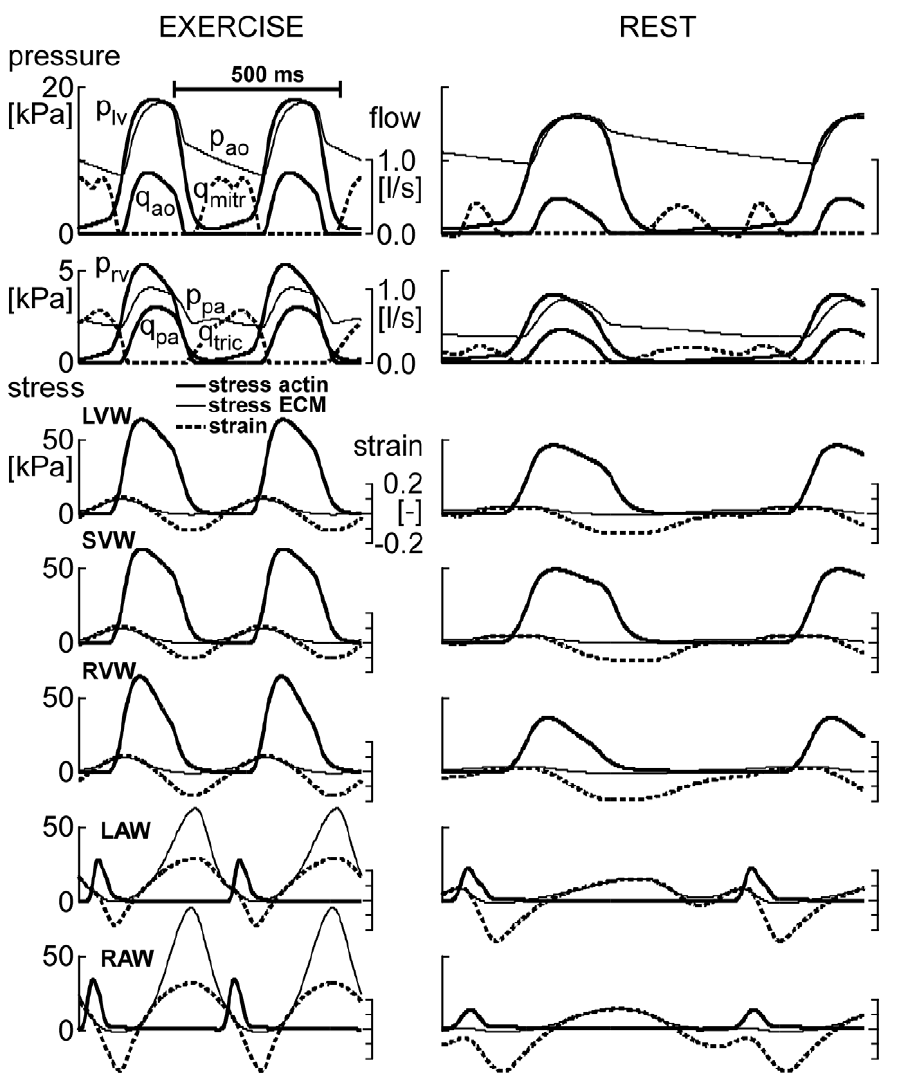
Figure 4. Simulation of circulation dynamics and cardiomechanics. With the CircAdapt model, beat-to-beat circulation dynamics are simulated at moderate exercise (left) and at rest (right). Top: Pressures in left/right ventricle (p lv /p rv ) and aorta/pulmonary artery (p ao /p pa ), and flows through aortic/pulmonary (q ao /q pa ) and mitral/tricuspid valves (q mitr /q tric ). Lower panels: Stresses in actin and ECM of the 5 cardiac walls and related fiber strains. For exercise and rest, amplitude and time calibrations are the same. Abbreviations LAW, RAW, LVW, SVW, RVW are defined in Fig.